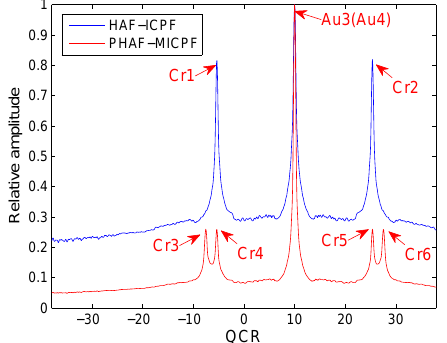
Figure 5. Cross-term suppression of PHAF-MICPF.